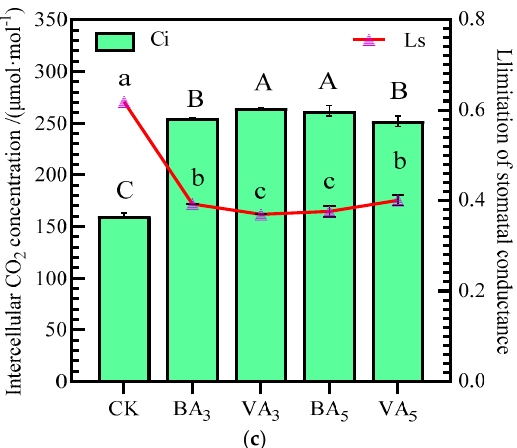
Figure 2. Effects of BA and VA rates on photosynthetic parameters of tomato leaves: ( a ) Effects of BA and VA rates on the Pn. ( b ) Effects of BA and VA rates on the Tr and Gs . ( c ) Effects of BA and VA rates on the Ci and Ls. Note: BA represents biochar application and VA vermicompost application. The meanings of the circles, triangles, and rectangles on the bars in ( a ) are indicated as duplicate data points for the different treatments. Means of Pn , Gs , and Ls are significantly different between BA and VA rates ( p ≤ 0.05) when followed by different lowercase letters. Means of Tr and Ci are significantly different between BA and VA rates ( p ≤ 0.05) when followed by different uppercase letters.Meanwhile, the increase in Pn in BA 3 , VA 3 , BA 5 , and VA 5 was accompanied by a decrease in Ls and an increase in Ci , Tr , and Gs . As shown in ( b ), the highest and lowest T r rates were observed for BA 3 and CK treatments, respectively, and BA 3 and VA 3 showed no statistically